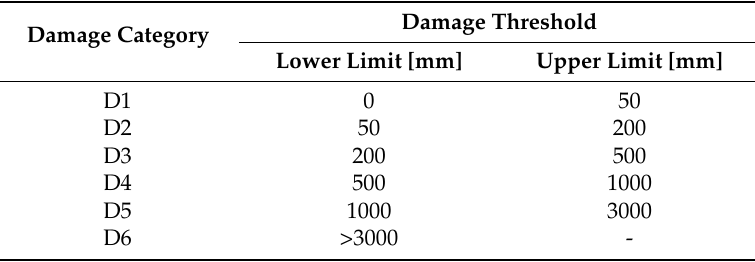
Table 4. Thresholds of damage size of six damage